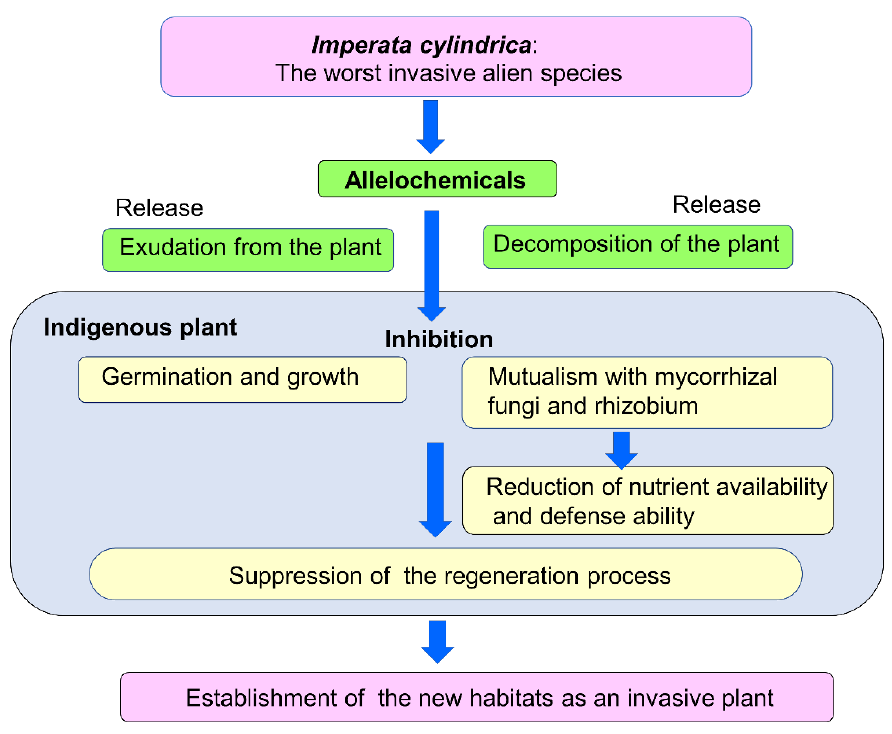
Figure 3. A possible scheme of I. cylindrica to establish the new habitats.